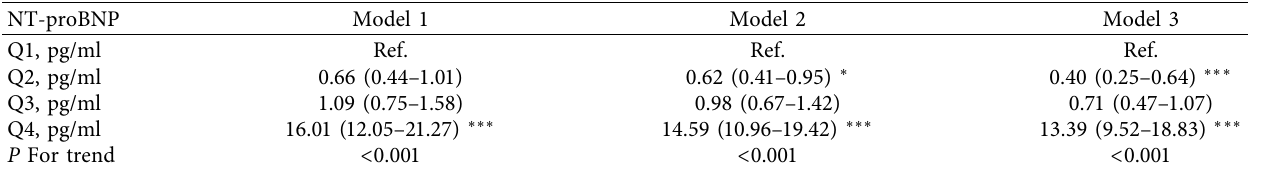
Table 4: Association between NT-proBNP and the risk of in-hospital